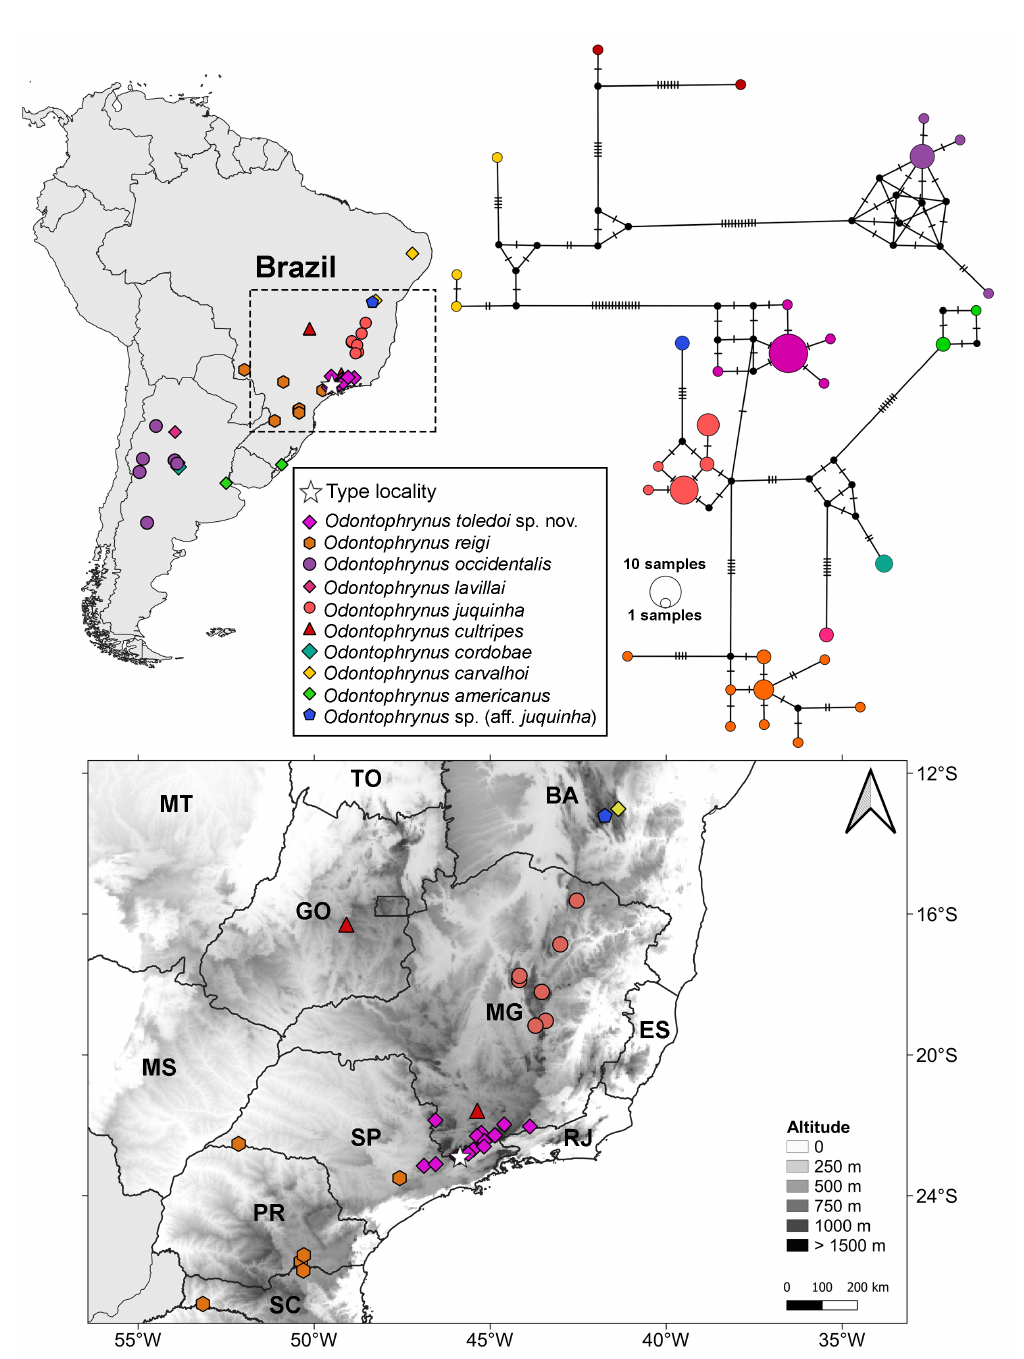
Fig. 10. Geographical distribution of ten species of Odontophrynus Reinhardt & Lütken, 1862 in South America and the respective haplotype network with the colors of each cluster also indicated on the map. Median-joining haplotype network of specimens from genus Odontophrynus based on partial sequences of the 16S mtDNA gene. Each haplotype is represented by a circle whose area is proportional to its frequency. Traits indicate additional mutational steps for branches with more than one mutation. Different colors indicate species-level units. The black dots are median vectors (hypothesized sequences). Highlighted, the altitude map shows the distribution of the genus in central, south, and southeast of Brazil. Abbreviations: BA = Bahia; ES = Espirito Santo; GO = Goiás; MS = Mato Grosso do Sul; MT = Mato Grosso; PR = Paraná; RJ = Rio de Janeiro; SC = Santa Catarina; SP = São Paulo; TO =